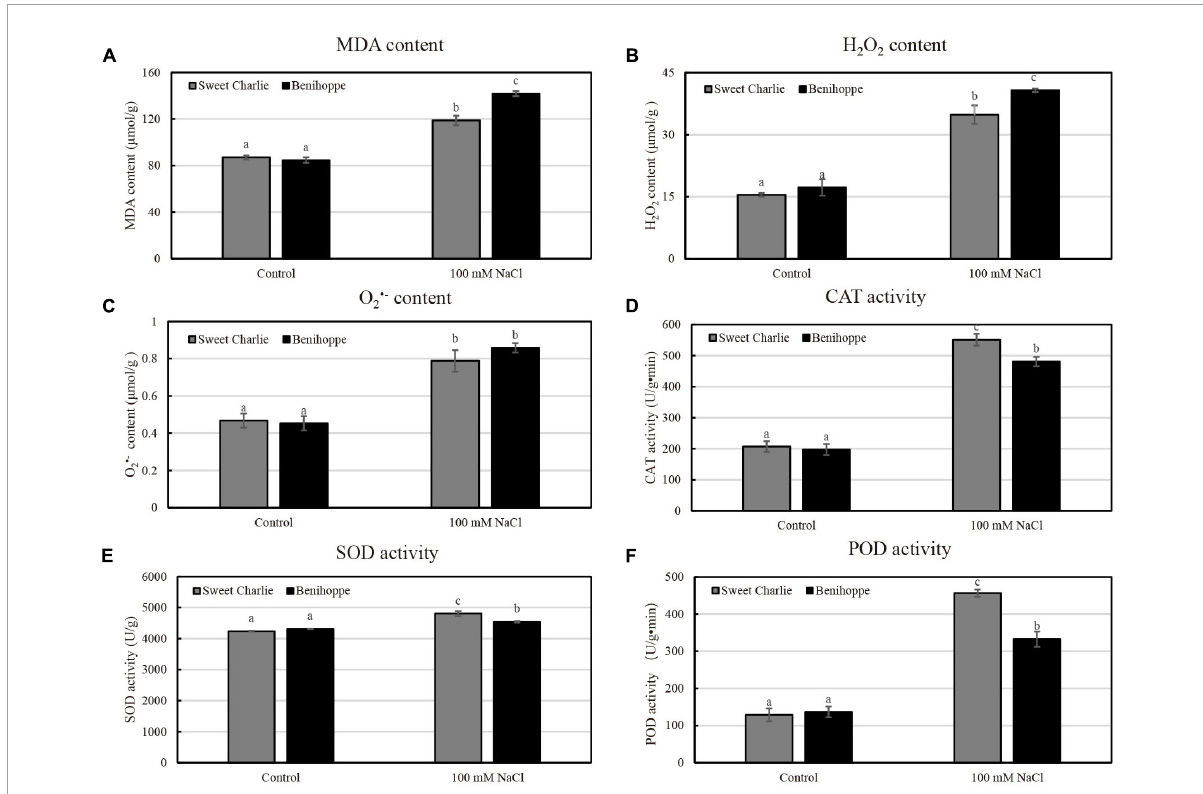
FIGURE3 Physiological indices analysis of strawberry under salt stress. ‘Sweet Charlie’ and ‘Benihoppe’ plants with 6–7 leaves were treated with 0 mM (control) or 100 mM NaCl solution, respectively. After 10 days of treatment, the young leaves were collected for physiological indices determination. The content of MDA (A) , H 2 O 2 (B) , and O 2 · - (C) under control and salt stress treatment in strawberry leaves. The activities of CAT (D) , SOD (E) , and POD (F) under control and salt stress treatment in strawberry leaves. Data are means ( ± SD) of three independent experiments. Different letters indicate significant differences ( P <